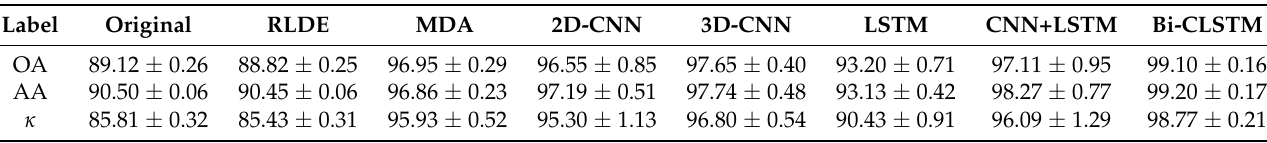
Table 10. OA, AA, per-class accuracy (%), κ and standard deviations after five runs performed by eight methods on the Pavia University Scene dataset using 3921 pixels as the training